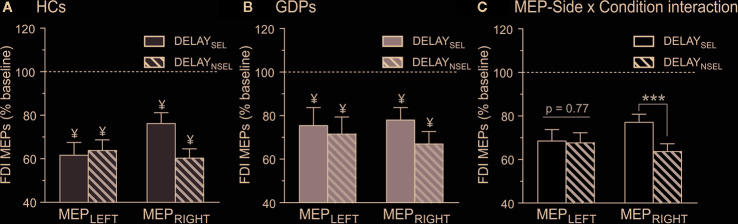
Neural measures of preparatory suppression. Amplitude of motor-evoked potentials (MEPs) recorded at TMSDELAY, expressed in percentage of MEPs elicited at TMSBASELINE-IN, shown for the left (MEPLEFT) and the right (MEPRIGHT) FDI, which was either selected (DELAYSEL; open bars) or non-selected (DELAYNSEL; dashed bars) for the forthcoming response in HCs (A) and GDPs (B). ¥ = significantly different from MEPs probed at TMSBASELINE-IN. (C) MEP-Side x Condition interaction. MEPs were larger in the selected relative to the non-selected condition only in the right FDI, regardless of the group. ***p < 0.001: significantly different.